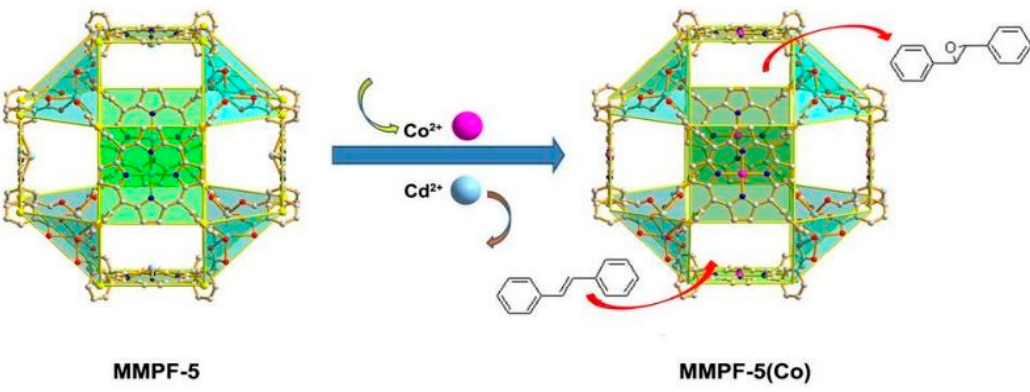
Figure 7. Schematic representation of MMPF-5(Co) preparation by post-synthetic modification, catalytically competent in trans -stilbene epoxidation. Adapted from http://sqma.myweb.usf.edu/ pages/publications.html#anchor2013.